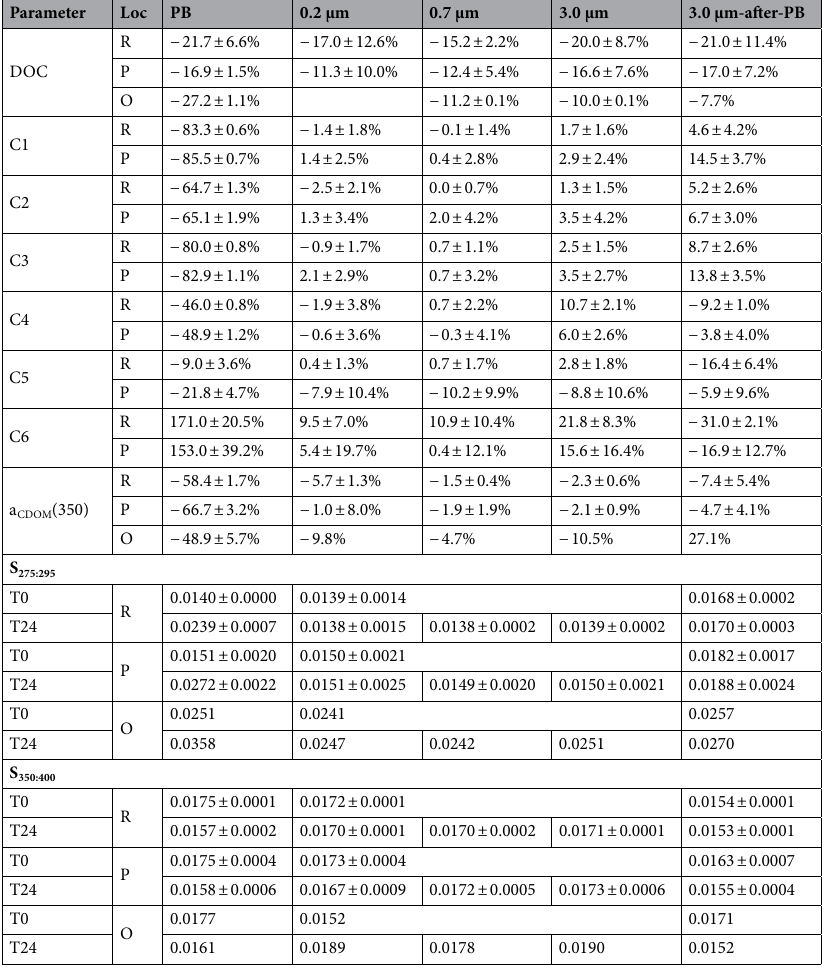
Table 1. Change in dissolved organic carbon concentration (%), fluorescent components (%), CDOM absorption at 350 nm (a CDOM (350); %) and spectral slope from 275–295 and 350–400 nm (absolute change, nm −1 ) from day 0 to day 24. Values include standard deviation, calculated between stations (river and plume) or between replicates (ocean). Where standard deviation is absent, the value was zero. Stations are delineated by location (Loc), delineated by salinity, as river (R; ~ 0 psu), plume (P; 2.7–27.8 psu) and ocean (O; 31.2 psu). The number of stations considered for each group was 3, 6 and 1,